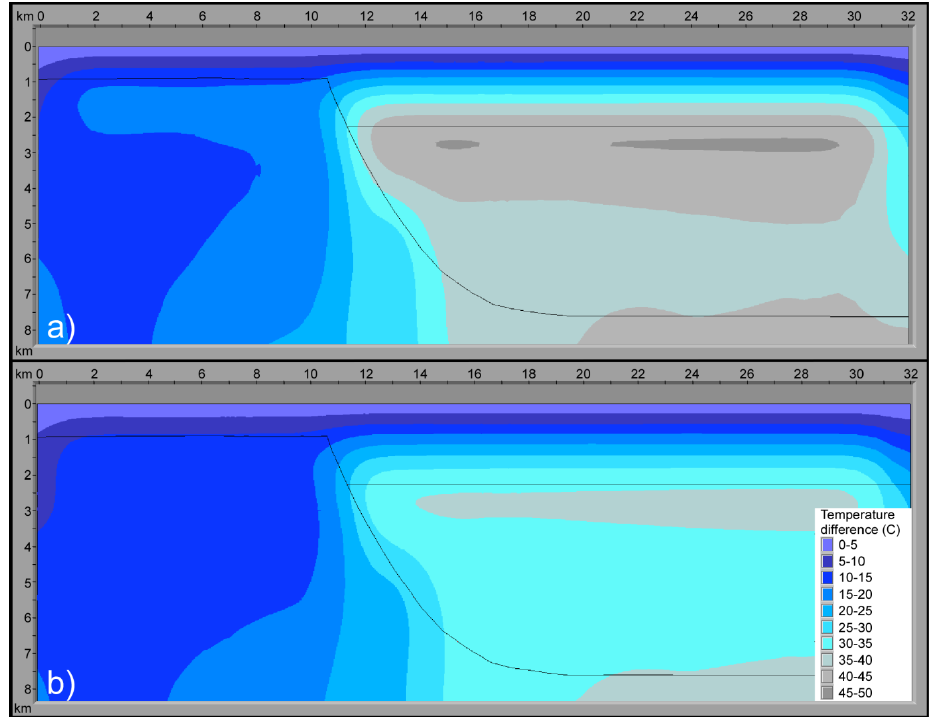
Figure 5. Temperature difference between steady state and transient model of the studied synthetic profile at 10 kyr ( a ) and 500 kyr ( b ) after fault displacement.